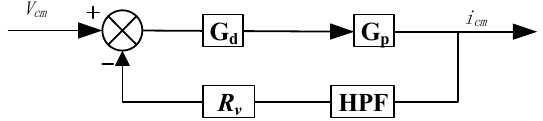
Figure 10. Common mode current suppression control loop.